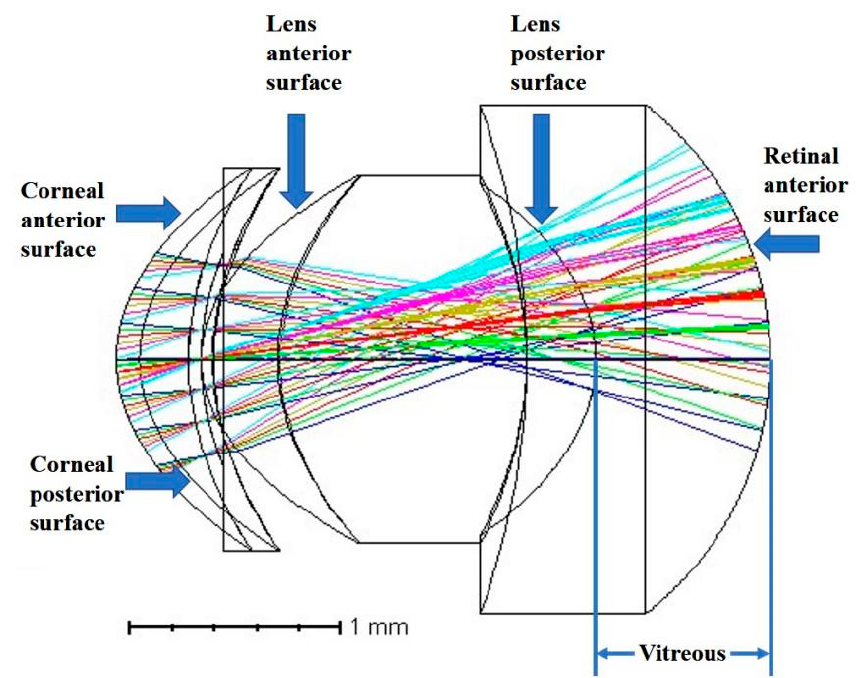
Figure 5. The ray-tracing model in ZEMAX software.